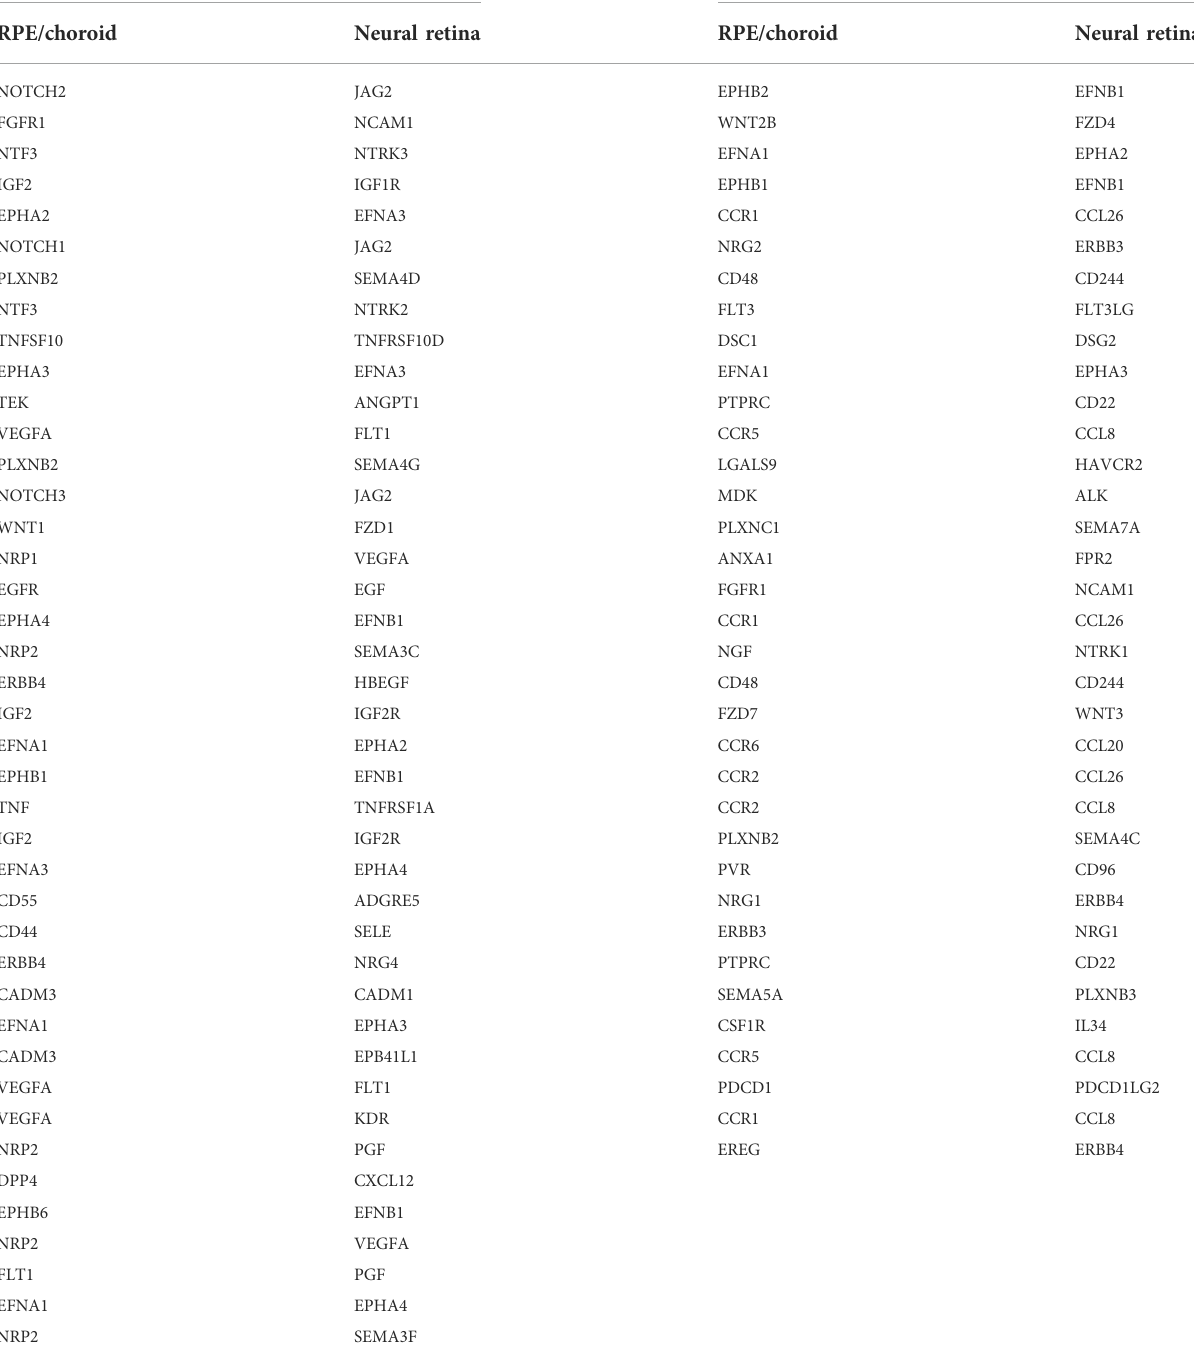
TABLE 2 Ligand-receptor interactions across neural retina and RPE/choroid in the macula. Upregulated interactions in the macula Downregulated interactions in the